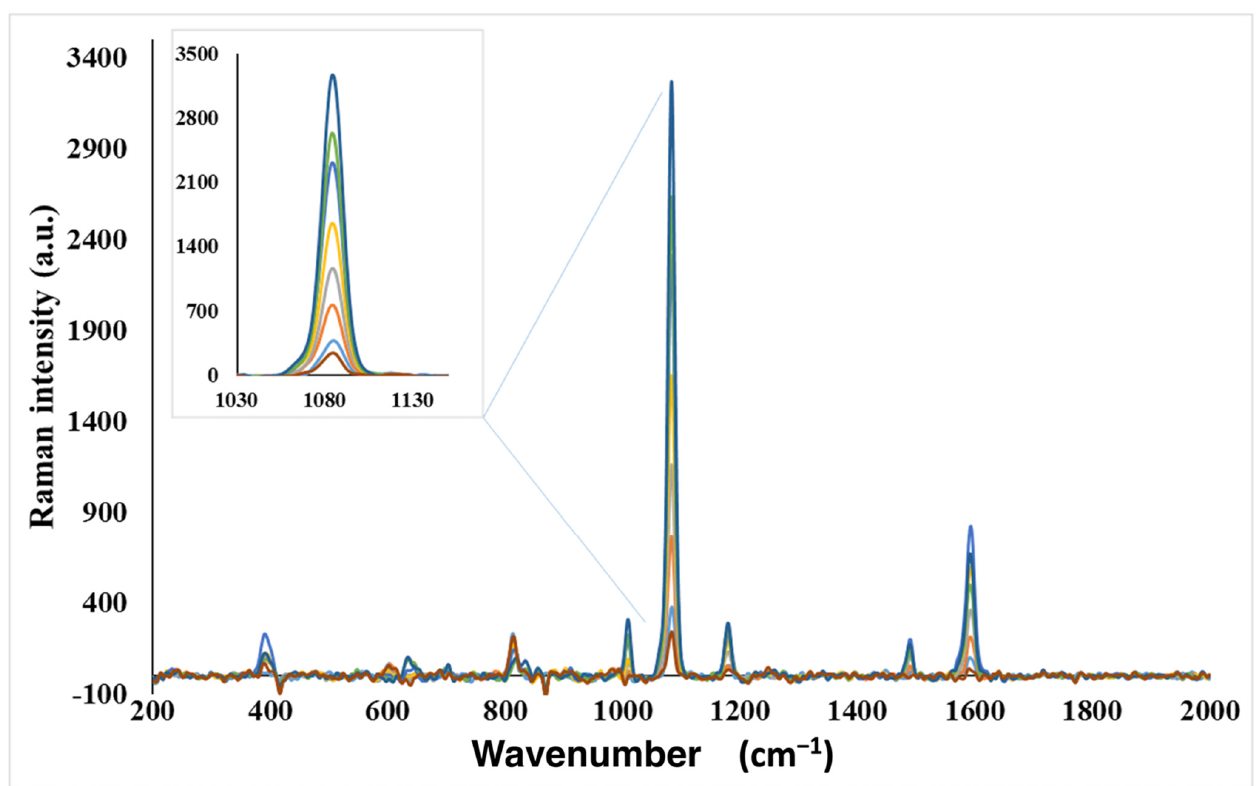
Figure 5. Typical SERS spectra obtained from target bacteria as a function of different initial logarithmic concentrations. Different color represents the increase of bacteria concentration.